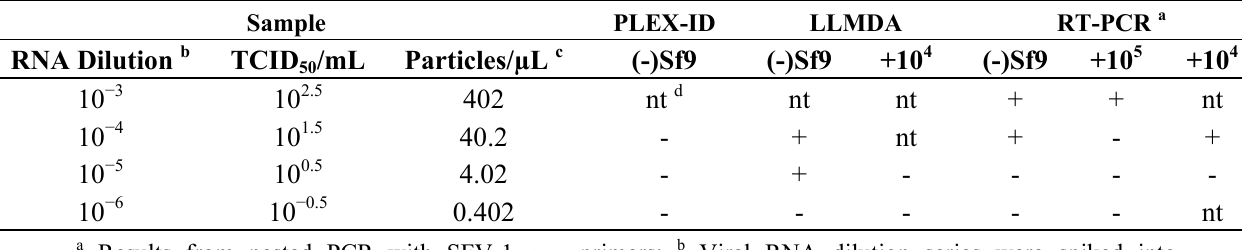
Table 2. Limit of detection using SFV-1 RNA